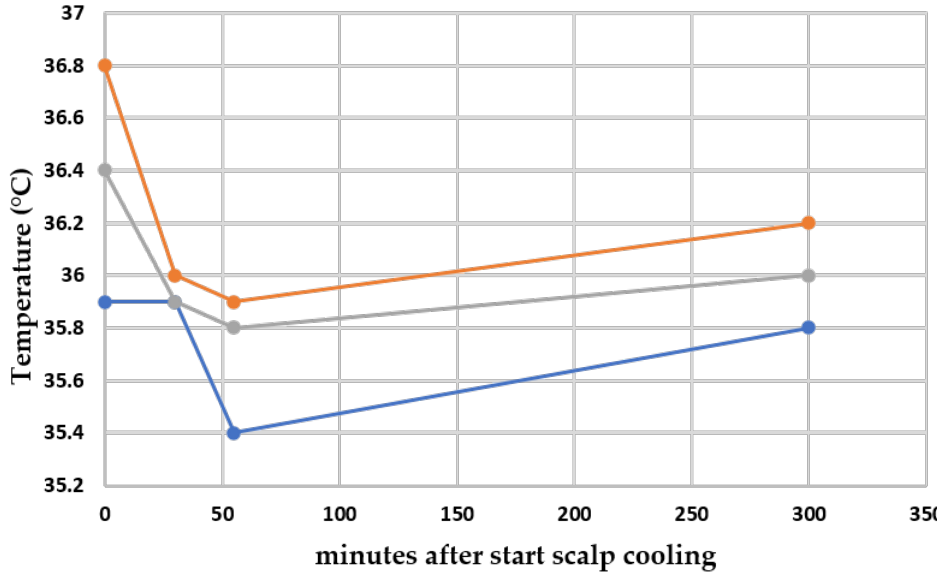
Figure 2. Course of median temperature during the scalp cooling of 14 patients in an ear, the mouth and an axilla. Locations of temperature measurements: orange line: an ear; gray line: the mouth; and blue line: an axilla.